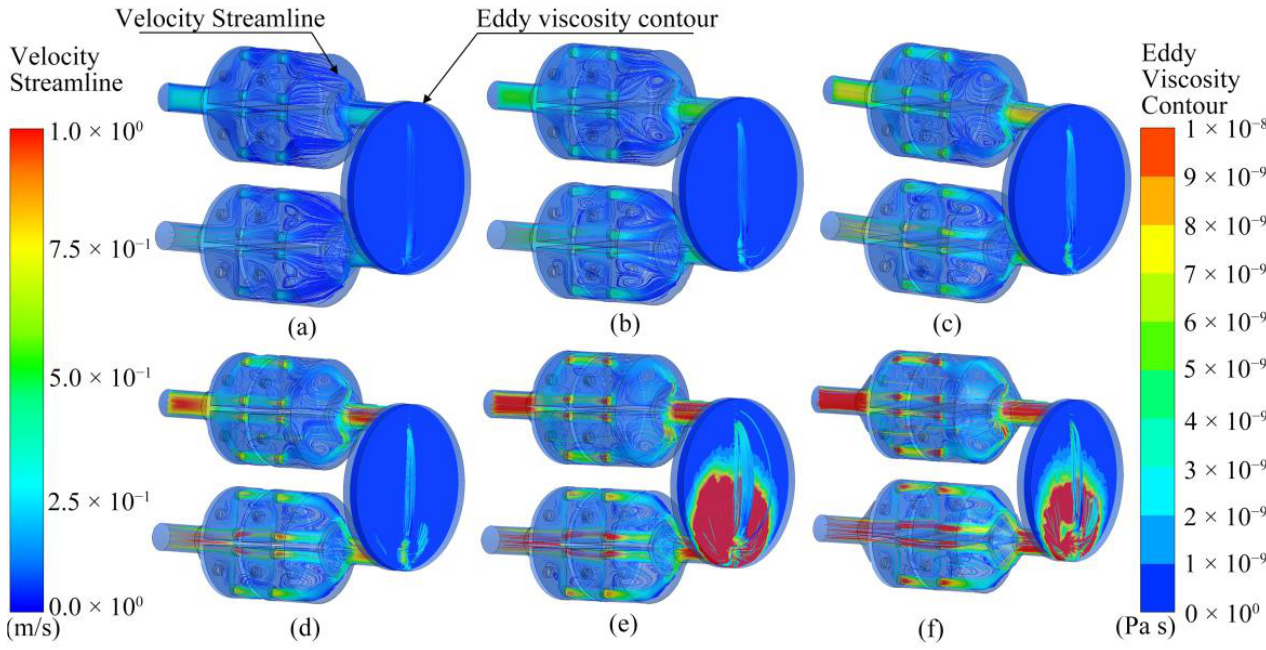
Figure 10. Simulation results of velocity streamline and eddy viscosity isoline in electronic nose chamber at six flow rates: ( a ) 200 SCCM, ( b ) 400 SCCM, ( c ) 600 SCCM, ( d ) 800 SCCM, ( e ) 1000 SCCM, and ( f ) 1200 SCCM. Parameter selection and optimization based on MR and GA-BP optimization